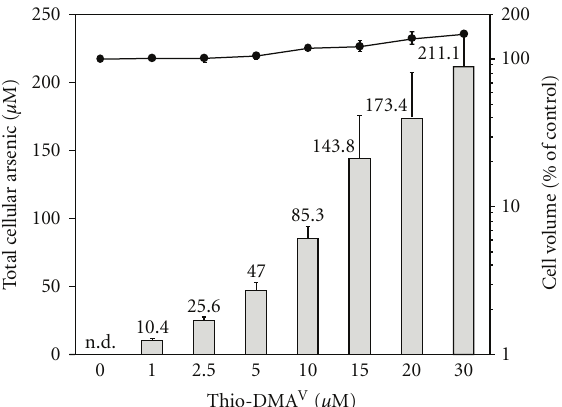
Figure 4: Cellular bioavailability of arsenic in A549 cells after 24h incubation with thio-DMA V . Logarithmically growing A549 cells were treated with thio-DMA V for 24 h, trypsinized, and cell number as well as cell volume was determined. Finally, arsenic was quantified by electrothermal atomic absorption spectroscopy. Shown are mean values of at least six independent determinations +/ ± SD; n.d.: below detection